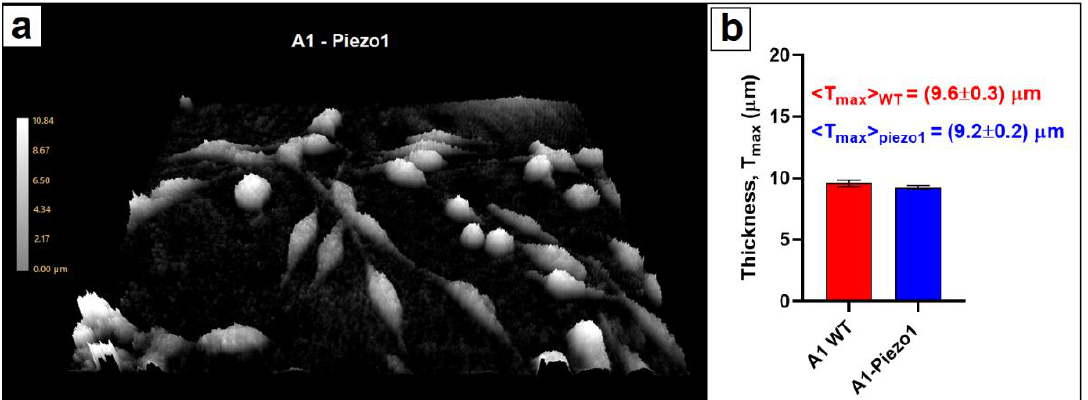
Figure 4. Cellular morphometry via digital holographic microscopy. ( a ) A 3D phase image re- construction of A1-Piezo1 cells. The scale (at left) relates the phase shift to the thickness (in µ m). ( b ) Assessment of the average maximal vertical thickness for A1 WT ( n = 45) and A1-Piezo1 ( n = 65) shows no significant morphological differences.